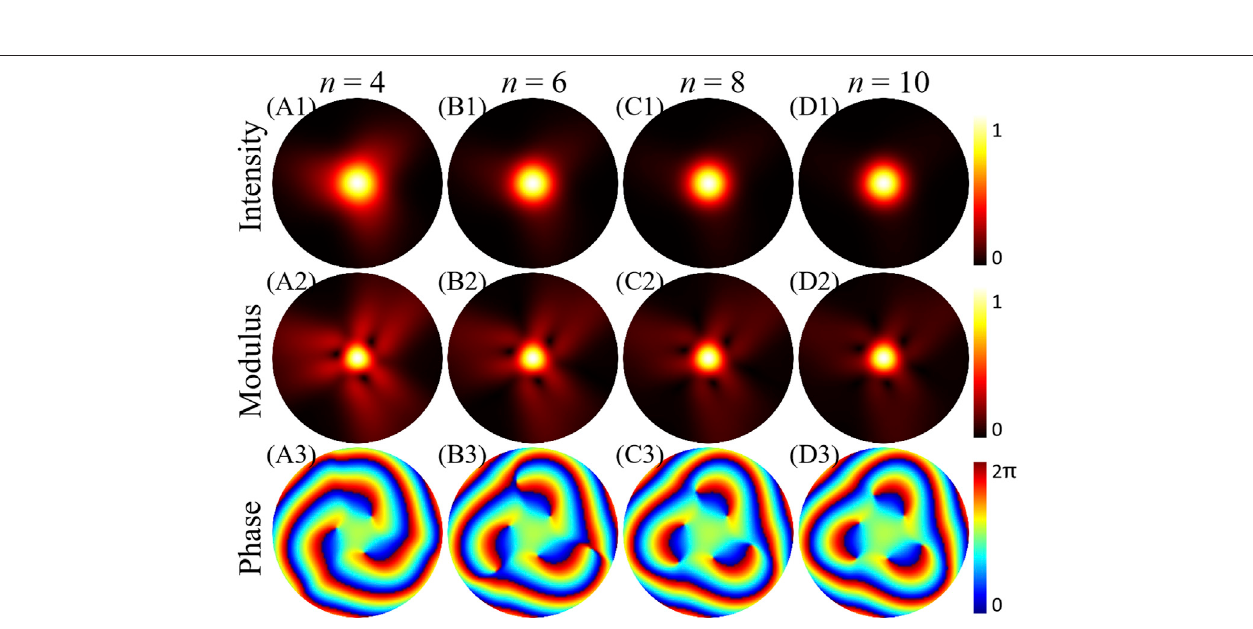
FIGURE 8 | Numerical simulation of intensities and CSD distributions of the PC-PEPV beams on the focal plane with TC m (cid:1) 3 and low spatial coherence ( σ (cid:1) 0.5 mm). (A1 – D1) are the intensity patterns, (A2 – D2) are the modulus of the CSD function, and (A3 – D3) are the phase patterns of the CSD function.